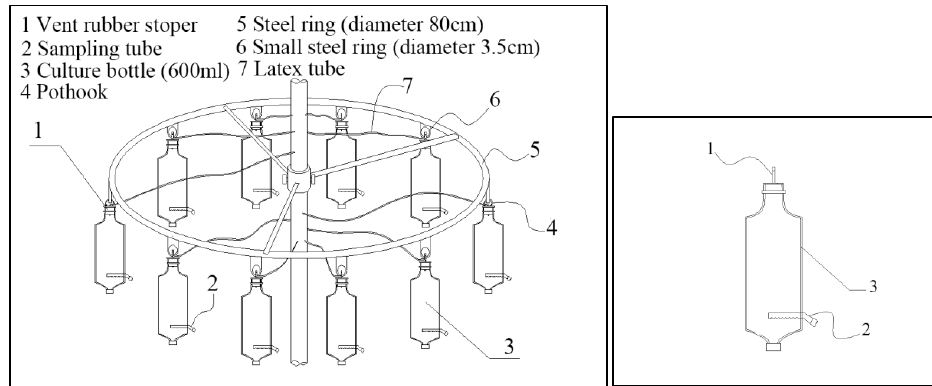
Figure 2. Diagram of the experimental apparatus used in this study.